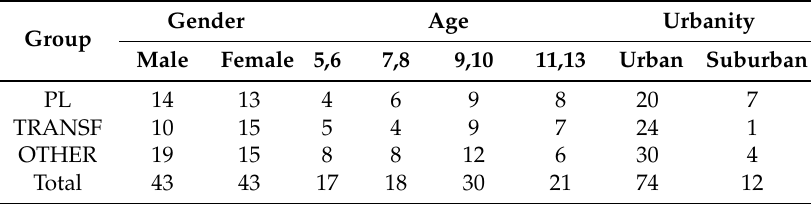
Table 1. Number of study participants for each measurements group (PL (Power Line) group, TRANSF (Transformer) group, OTHER group) divided per gender, age, and urbanity. Gender Age Group